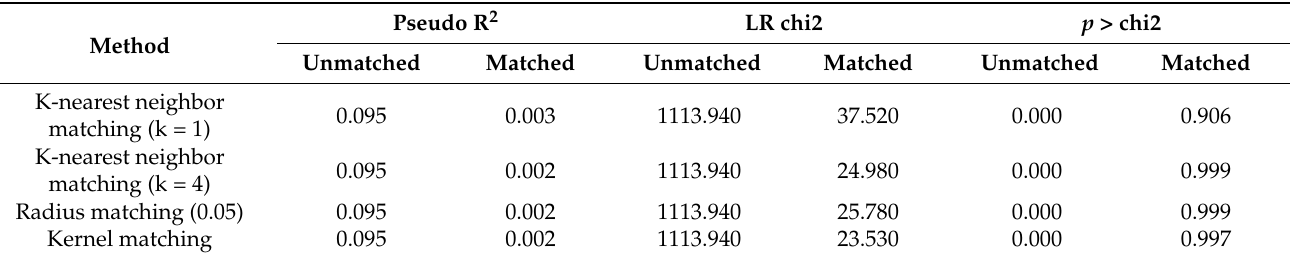
Table 5. Matching effect